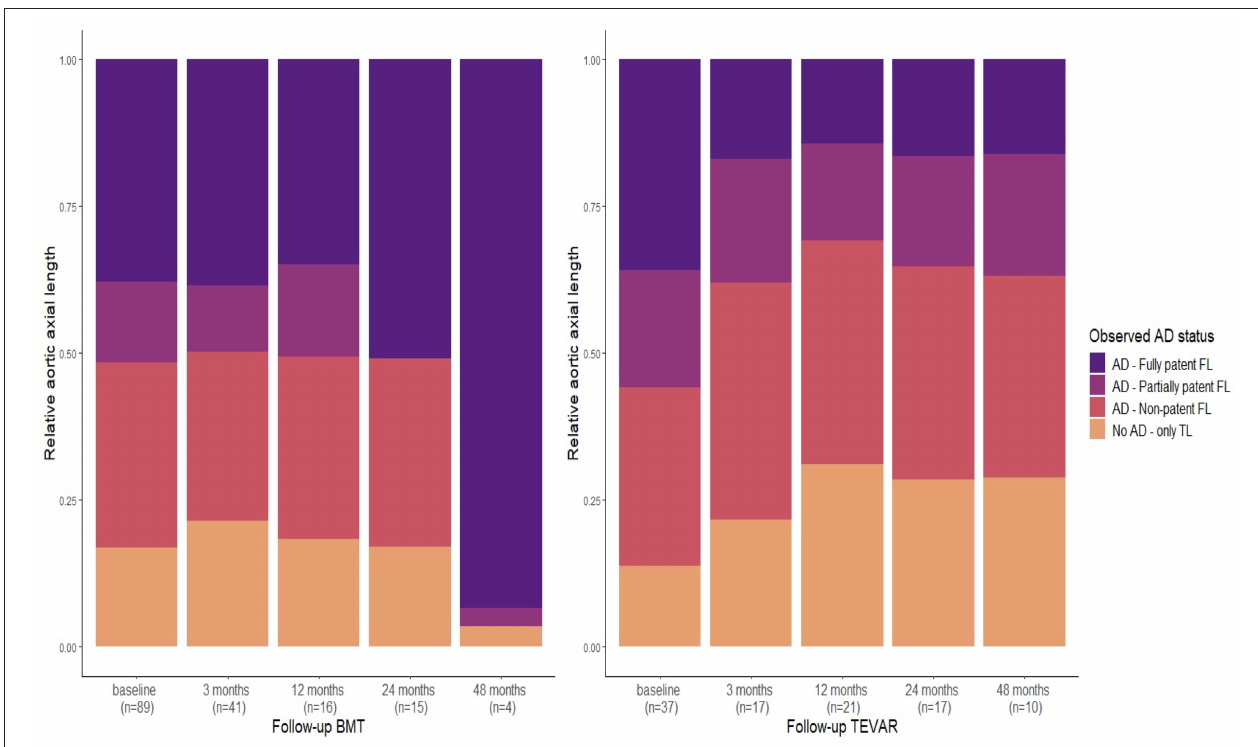
FIGURE 4 | Relative mean axial length of the aorta following assignement to one of the four patency status [fully patent false lumen (FL), partially patent FL, non-patent FL, and no aortic dissection (AD)—only true lumen (TL)] in patients with type B aortic dissection (TBAD) treated either by best medical treatment (BMT) or subsequent thoracic endovascular aortic repair (TEVAR) at 3, 12, 24, and 48 months follow-up (see also Supplementary Figure 1 ). “No AD—only TL” indicates the portion of the aorta where no AD/FL was observed (anymore). Note that TEVAR treatment reduces the relative portion of the fully patent FL, while the same is not true for the partially patent